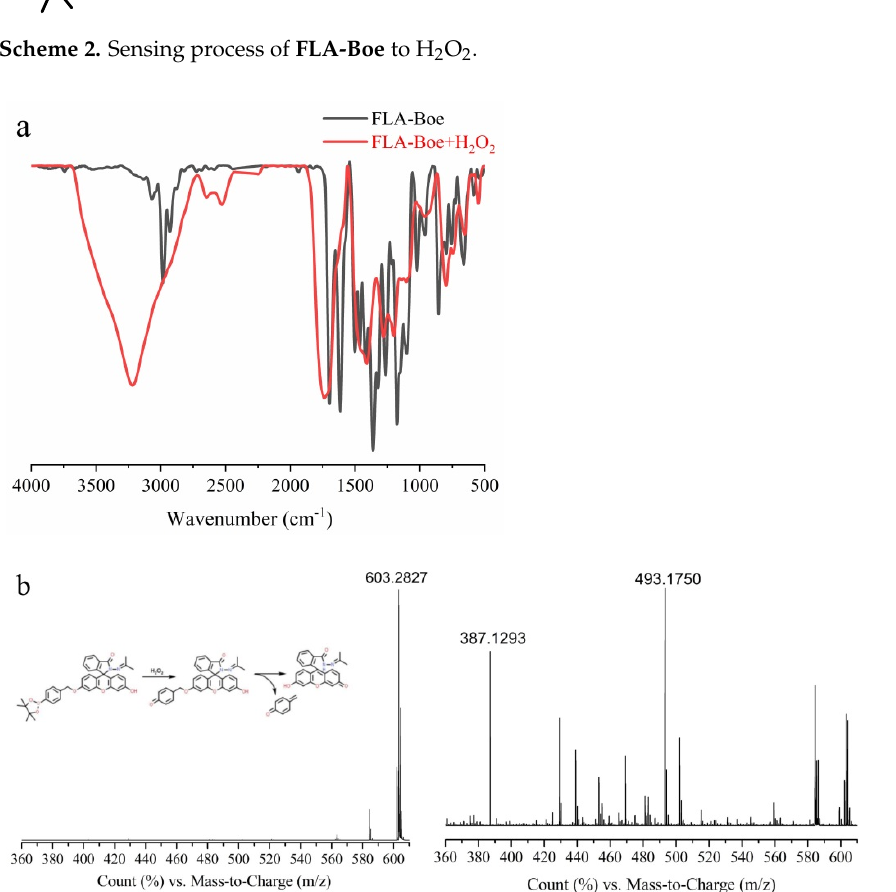
Figure 5. ( a ) FT-IR of FLA-Boe and FLA-Boe − H 2 O 2 , ( b ) HRMS of FLA-Boe and FLA-Boe − H 2 O 2 .